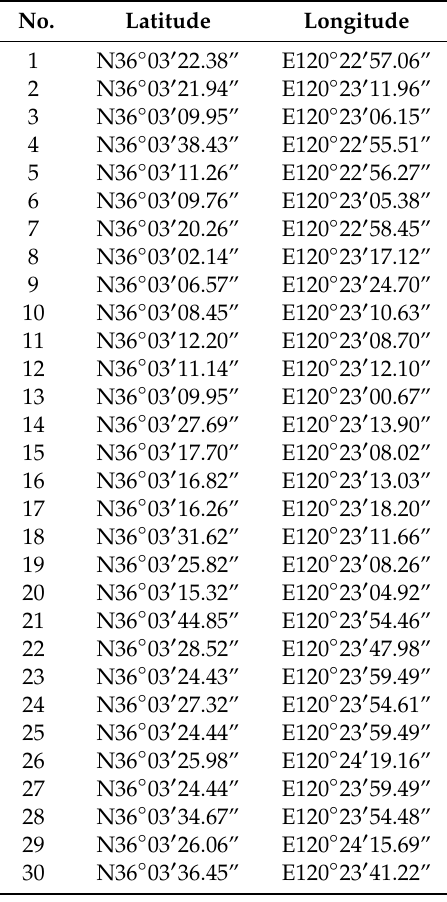
Table A3. Location coordinates of 35 planned